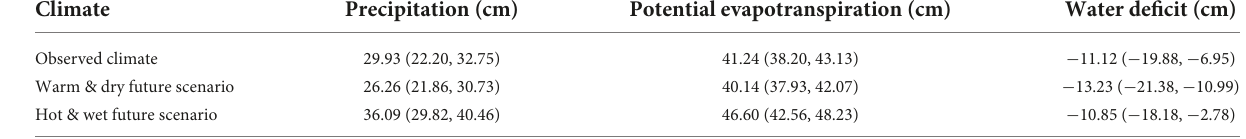
TABLE 4 Summer June/July/August precipitation, potential evapotranspiration, and water deficit (P–PET) for the climate scenarios in this study. Reported values are the median and bounds of the 67% highest density continuous interval of seasonal total precipitation by observed or projection